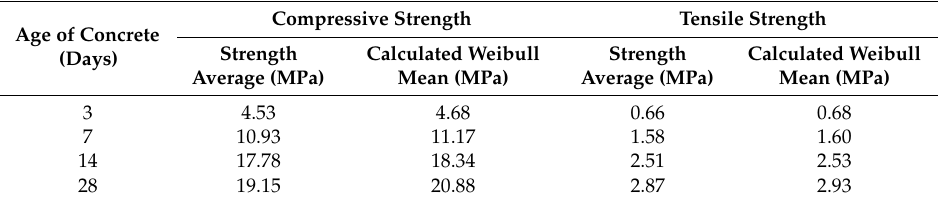
Table 5. Concrete compressive and tensile